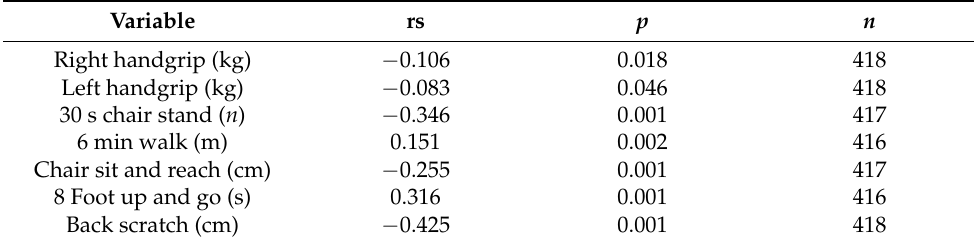
Table 4. Correlation between the Fitness variables and